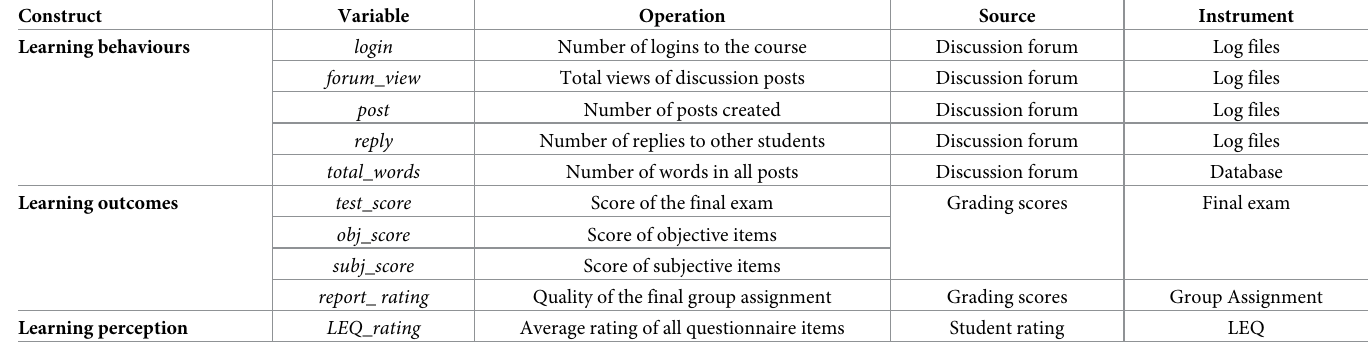
LEQ, learning experience